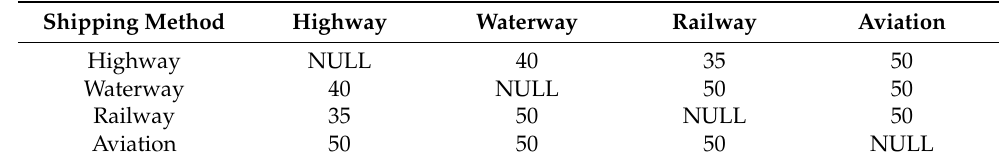
Table 2. Average speed of transit between different modes of transport (km/h).